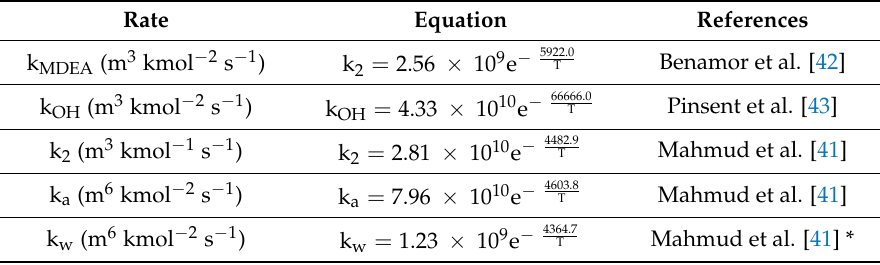
Table 2. List of rate expressions used for zwitterion